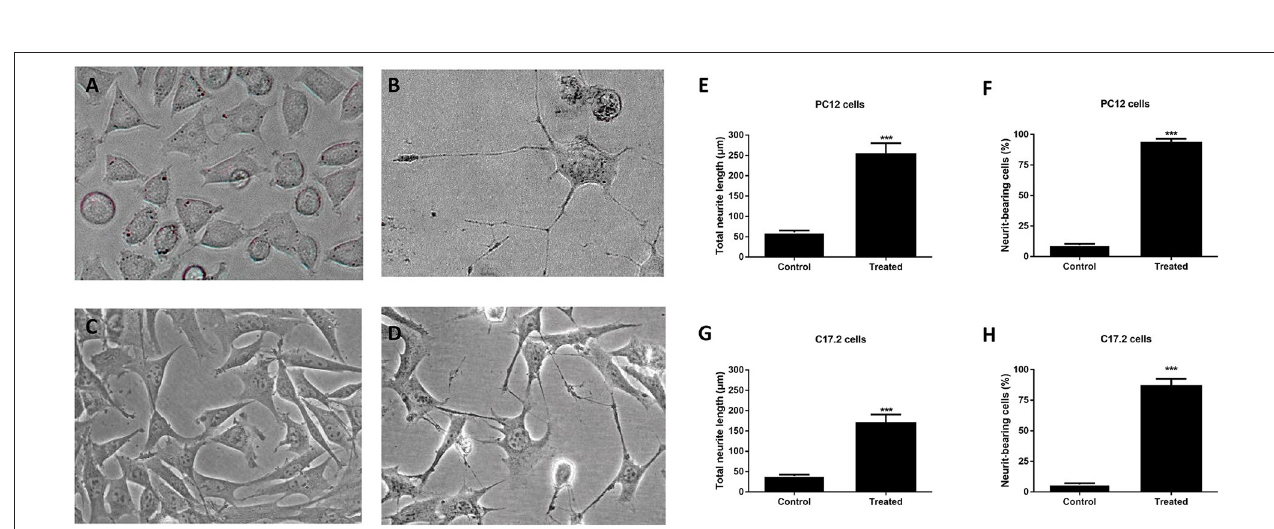
FIGURE 3 | Neurite outgrowth of PC12 cells and C17.2 cells treated with culture supernatant of M. smegmatis . Changes of neurite length in PC12 and C17.2 cells were observed after being stimulated with M. smegmatis culture supernatant for 48h. Cell morphologies of PC12 cells (A,B) and C17.2 cells (C,D) treated with M. smegmatis culture supernatant were observed respectively ( × 40); Neurite length and neurite-bearing cells of PC12 cells (E,F) and C17.2 cells (G,H) treated with M. smegmatis culture supernatant respectively. Quantitative results are presented as means ± S.D. for 3 replicates. *** P < 0.001, vs. control group, n = 3.